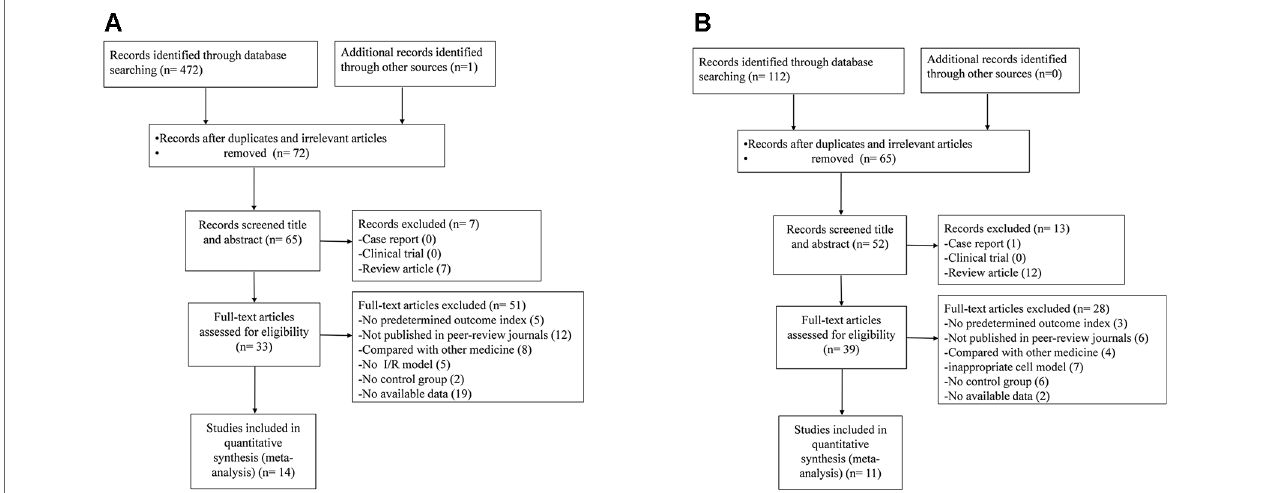
FIGURe 2 | Summary of the process for identifying candidate studies. (A) Search strategy for animal experiments: 473 potentially relevant studies were identified; after removal of duplicates and the application of inclusion and exclusion criteria, 14 studies were included in the meta-analysis. (B) Search strategy for cell experiments: 112 potentially relevant studies were identified; after removal of duplicates and the application of inclusion and exclusion criteria, 11 studies were included in the meta-analysis.